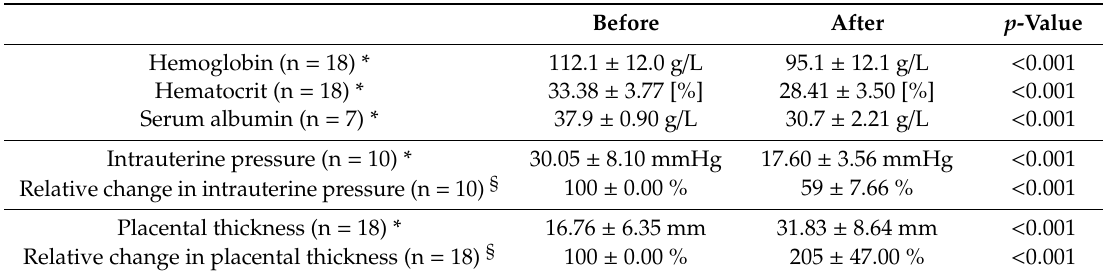
Table 2. Perioperative maternal blood characteristics and intraoperative measurements before and after amniodrainage.